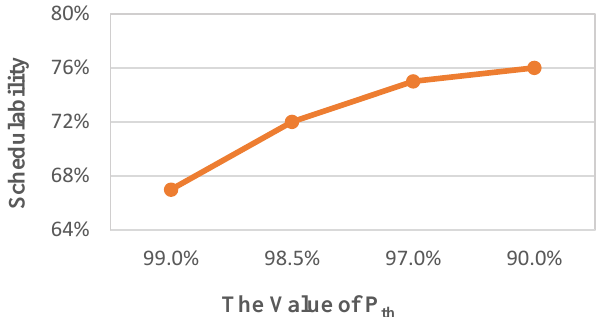
Figure 13. The average success rate of schedule among 50 test cases for varying load in: ( a ) Topol- ogy 2; ( b ) Topology 3.